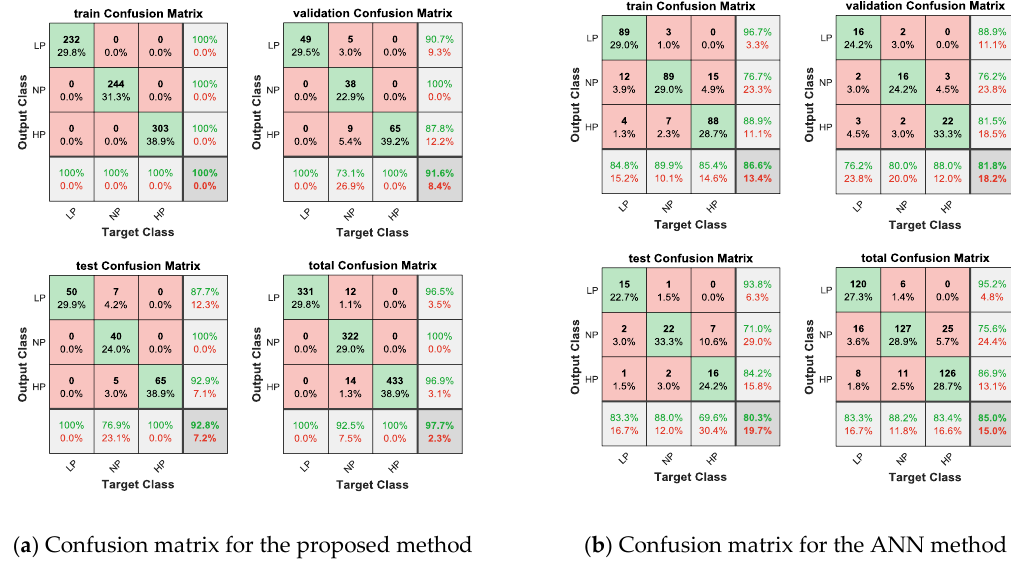
Figure 8. Confusion matrix for the proposed method and ANN method. Sensors 2020 , 20 , x FOR PEER REVIEW